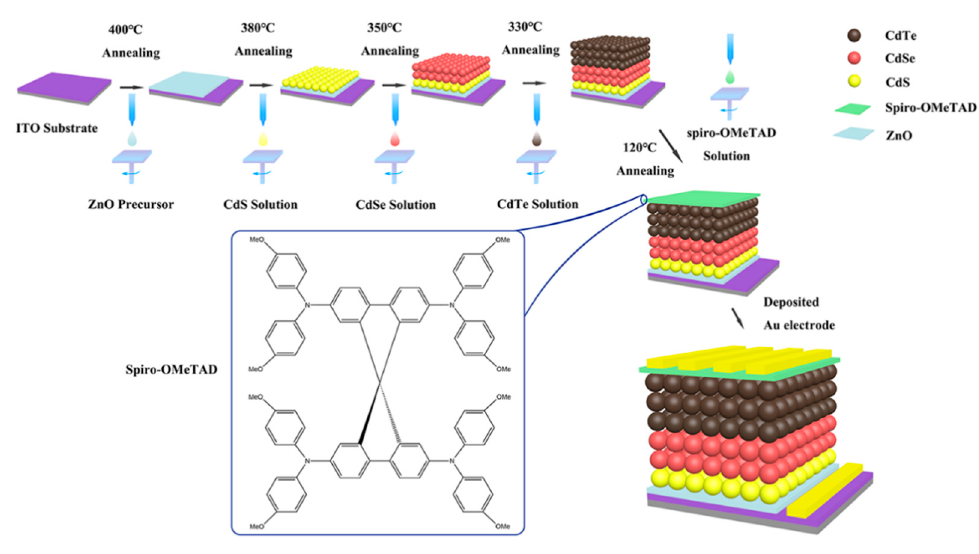
Figure 1. A schematic of the fabrication process of nanocrystal (NC) solar cells.